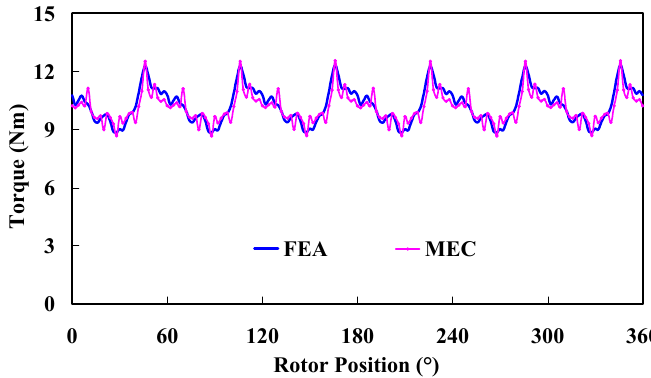
Figure 8. Torque vs. rotor positions when 30 A is applied.